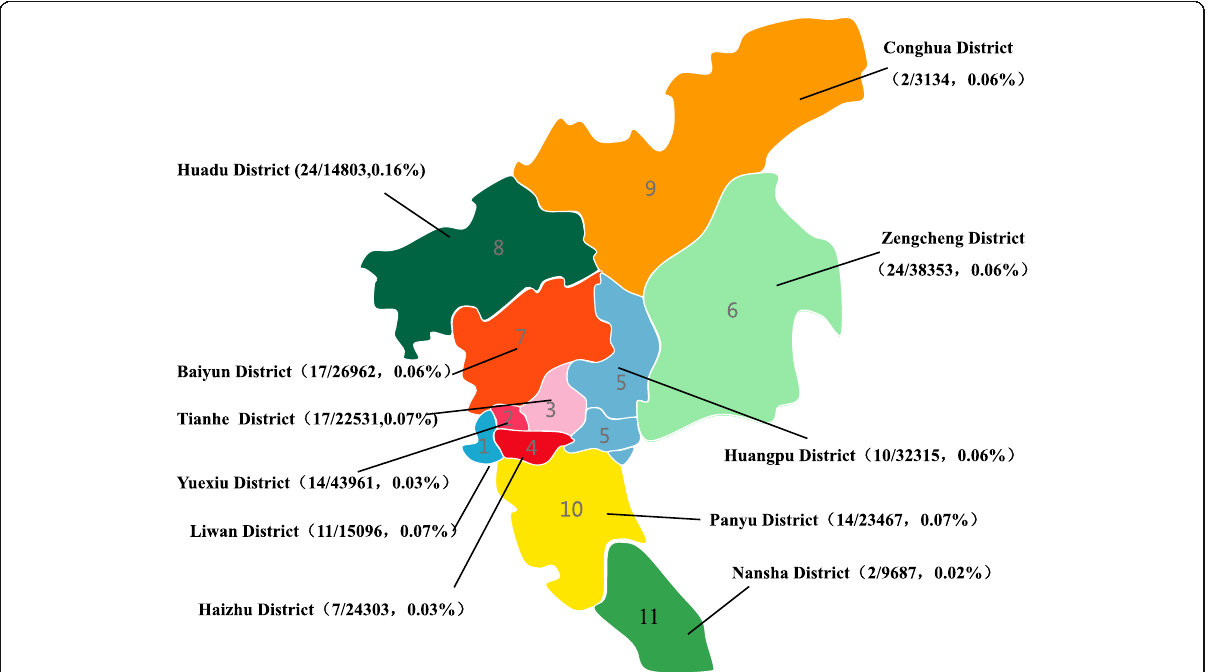
Fig. 3 Map showing the prevalence of Chinese G γ ( A γδβ ) 0 thalassemia and SEA-HPFH in Eleven districts of Guangzhou. (The number and percentage of those two types of δβ thalassemia/HPFH are indicated in detail). The carrier rate of these two disorders in eleven districts of Guangzhou is shown in Fig. 3. It was 0.06% in Guangzhou, which was similar in most districts except for Huadu and